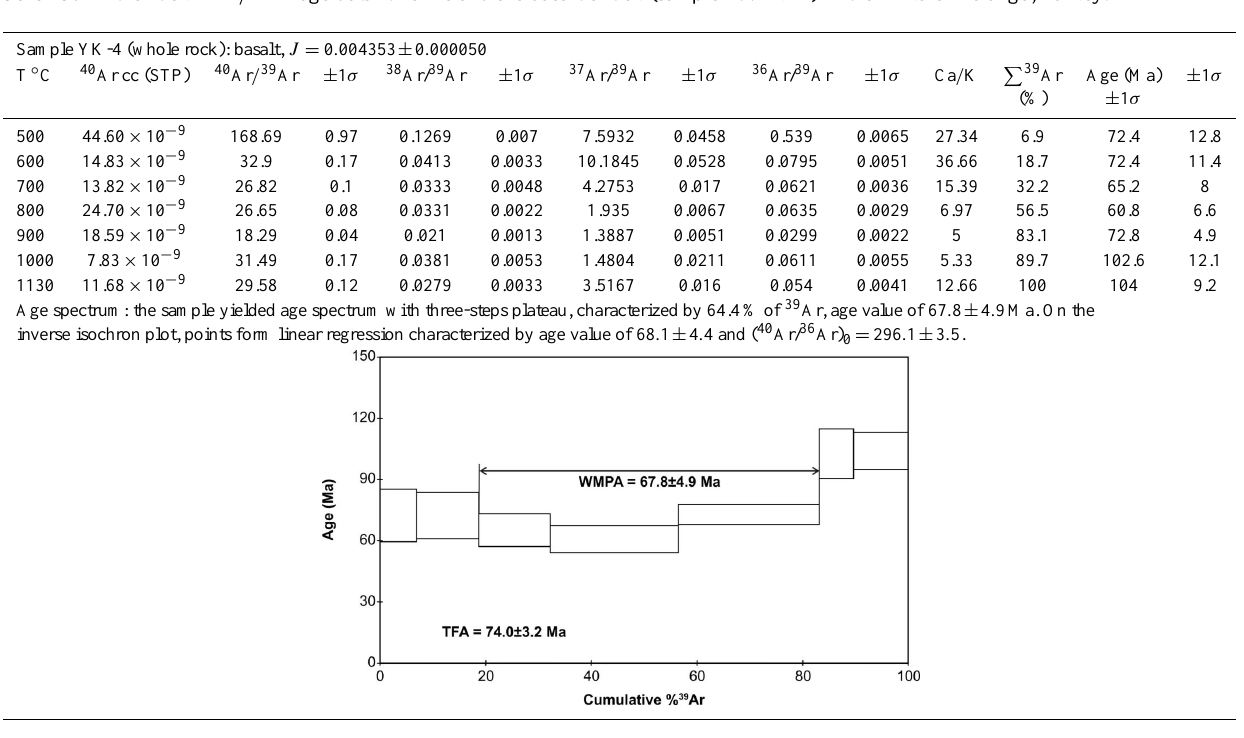
Table 4a. Whole-rock 40 Ar / 39 Ar age data for an island arc basaltic rock (sample no. YK-4) in the Ankara Mélange, Turkey.